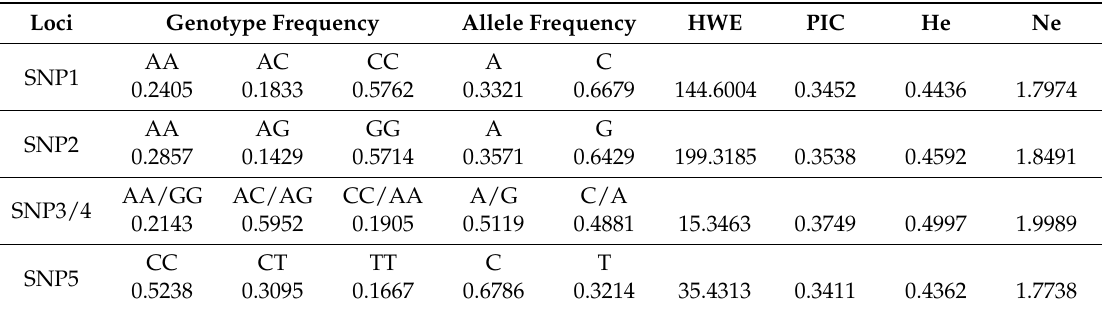
Table 1. Genotypes, Minor Allele Frequency, Hardy-Weinberg equilibrium (HWE), He, Ne, and PIC for the five SNPs.